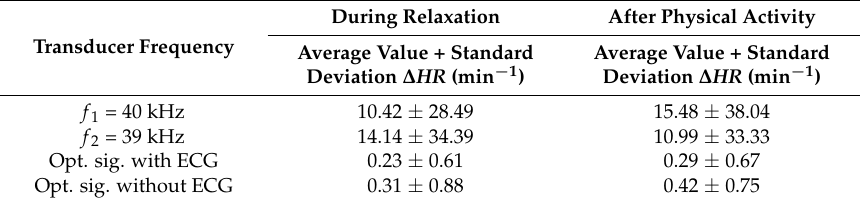
Table7. Average and standard deviation of HR parameters for the laboratory group. Table 7. Average and standard deviation of HR parameters for the laboratory